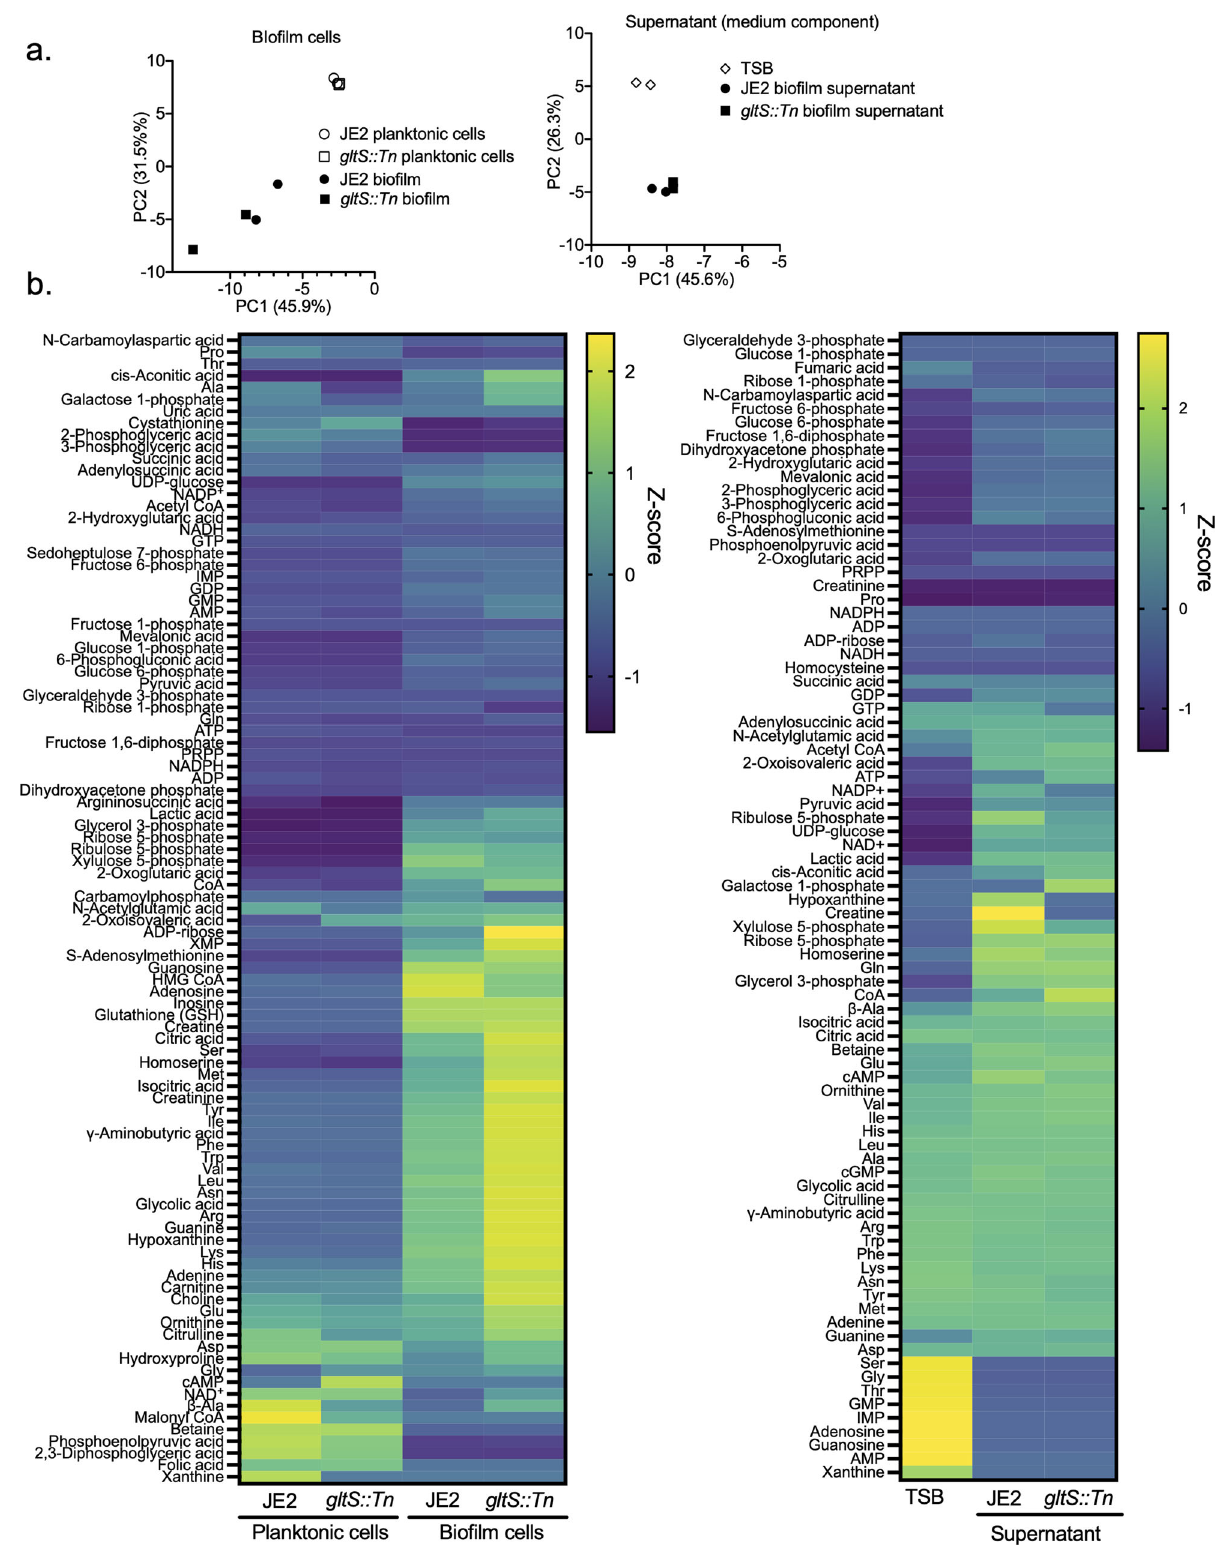
Fig. 4 Metabolome pro fi les of planktonic and bio fi lm cells and culture supernatants. a Principal component analysis (PCA) of metabolites in bio fi lm cells (left) and supernatant, showing the top two on the x-axis and y-axis, respectively. For supernatant analysis, TSB indicates TSB containing 1% glucose without any bacteria co-culture. b Heatmap representation of metabolome pro fi les analyzed by hierarchical clustering.